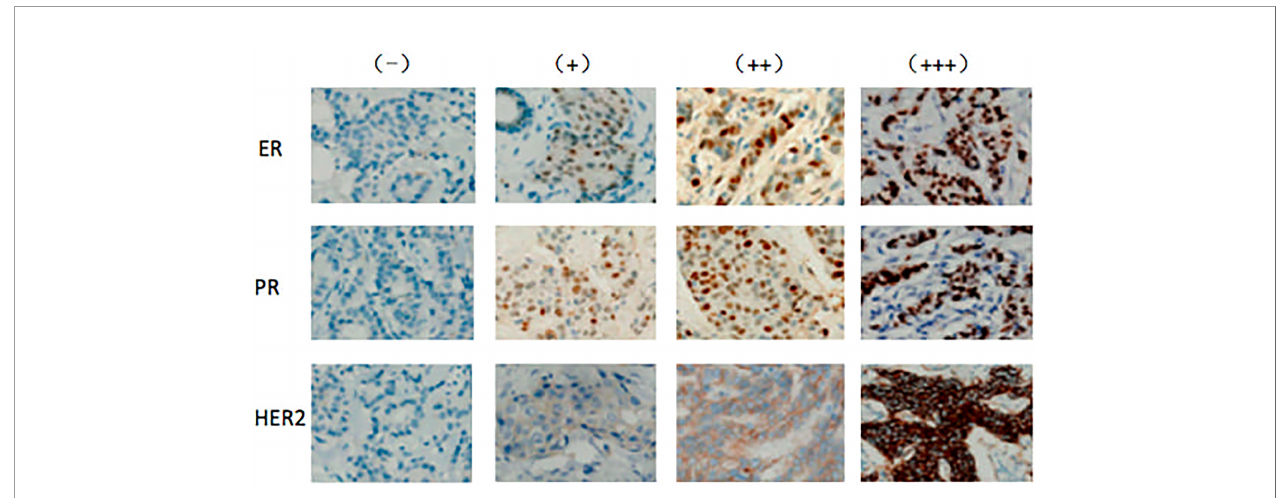
FIGURE 1 | Expression of ER, PR, and HER2 in PMP patients with breast cancer Expression levels of ER, PR, and HER2 were determined by immunohistochemistry and assessed by staining intensity from no expression ( − ) to weak (+), intermediate (++), and strong (+++)